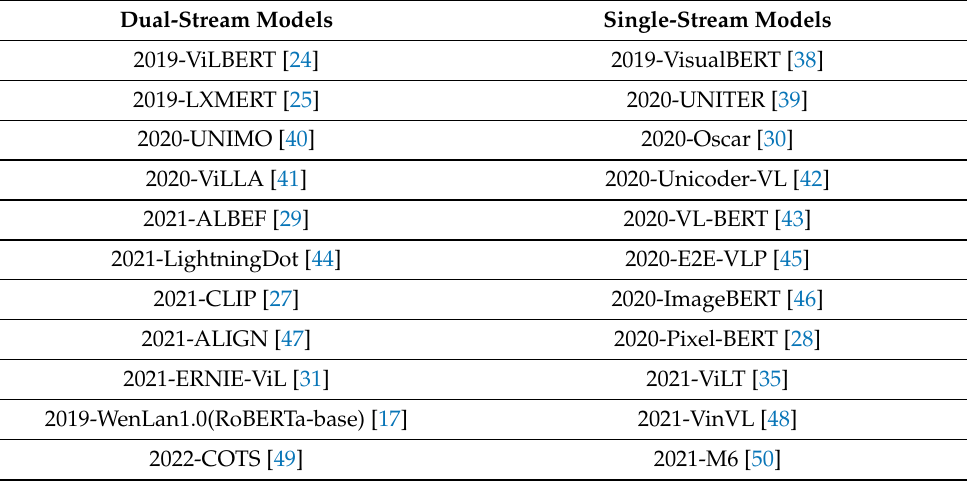
Table 1. A road map table for pre-training models with fusion encoder and dual